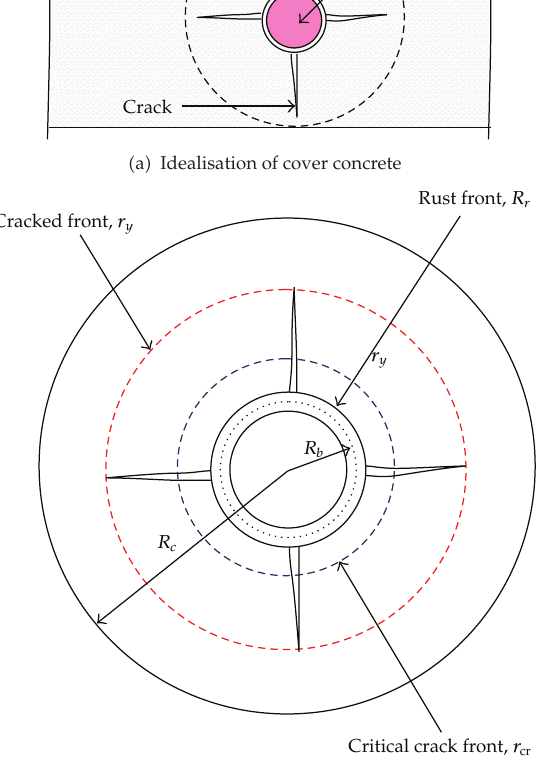
Figure 1: Thick-walled cylinder model for cover concrete cracking evolution due to reinforcement